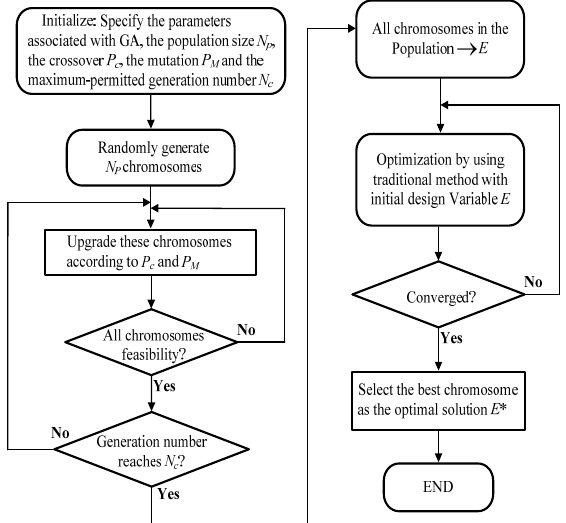
Figure 3. Flow chart of hybrid genetic algorithm (HGA) for CCP ‐ based optimization procedure.